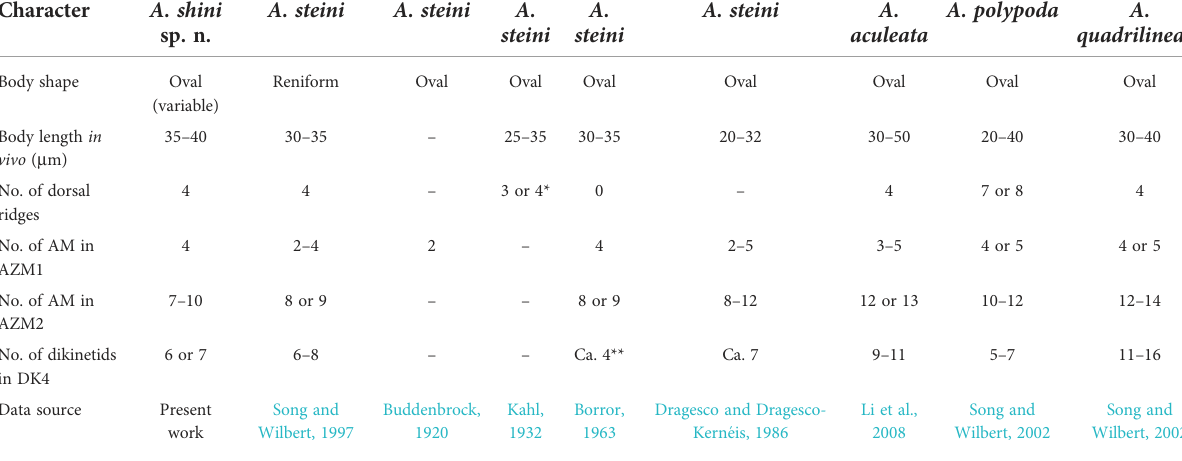
TABLE 3 Comparison of Aspidisca shini sp. n. with some related